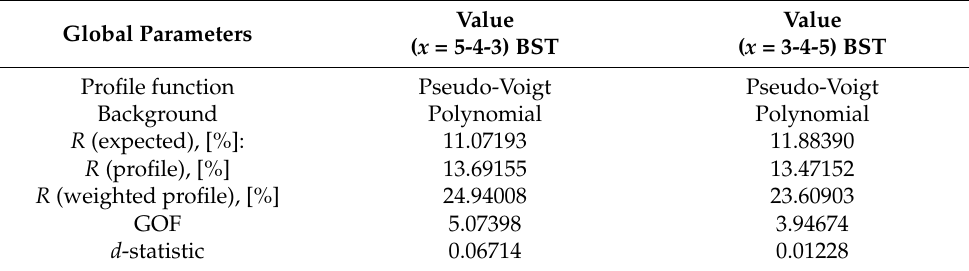
Table 3. Global parameters of the Rietveld method fitting used for structural parameters’ refinement for “up-” and “down-graded” BST thin films deposited on stainless-steel. Global Parameters